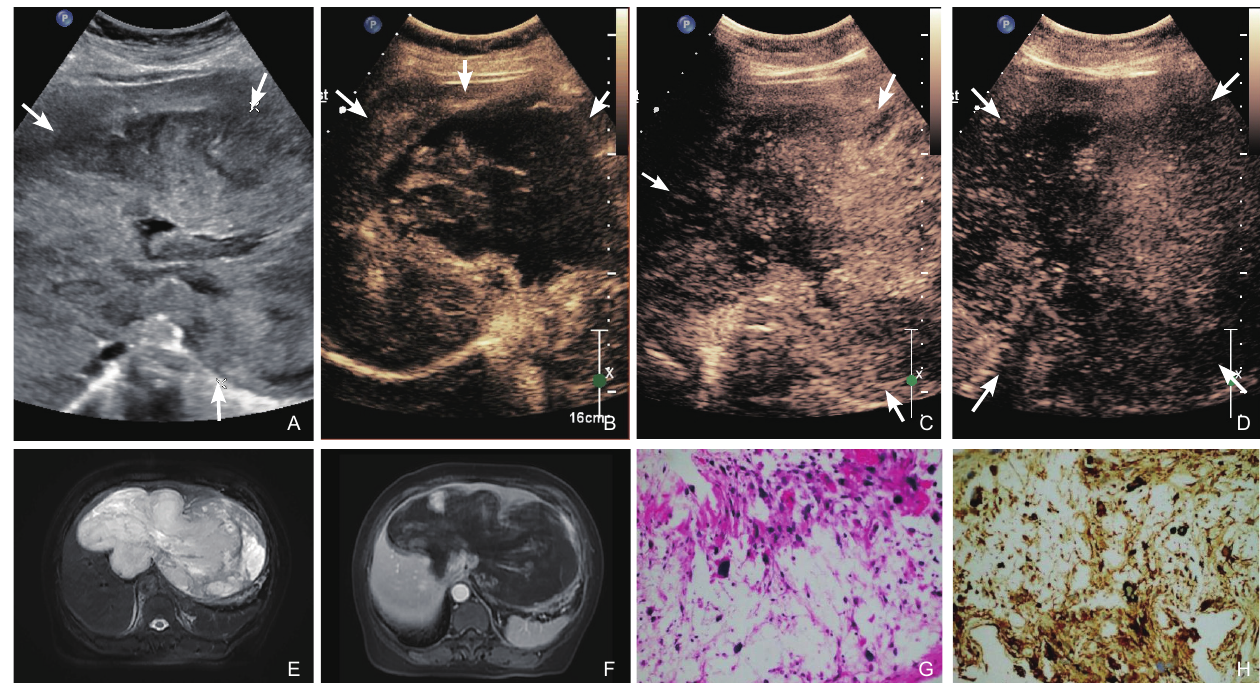
Figure 1 Undifferentiated embryonal sarcoma of the liver (UESL) in a 76-year-old woman. (A) B-mode ultrasound (BMUS) showing a mixed echoic solid mass with irregular shape and relative clear boundary; (B-D) On contrast-enhanced ultrasound (CEUS), the nodule displayed rim hyperenhancement (arrows) followed by progressive centripetal fill-in (star) during the arterial phase, and gradually became hypo-enhancement in the portal venous and lated phase. Area of perfusion defection was observed; (E-F) On MRI, The nodule presented a irregular cystic appearance and showed hyperintensity on T2WI. Peripheral and progressive hyperenhancement were observed after contrast agent injection; (G-H) On histopathology, spindle-shaped cells and highly atypical cells were found within the tumor, accompanying by hemorrhage and necrosis (H&E staining; magnification: × 200). Immunohistochemical staining showed the tumor was positive for α-AT (magnification: ×